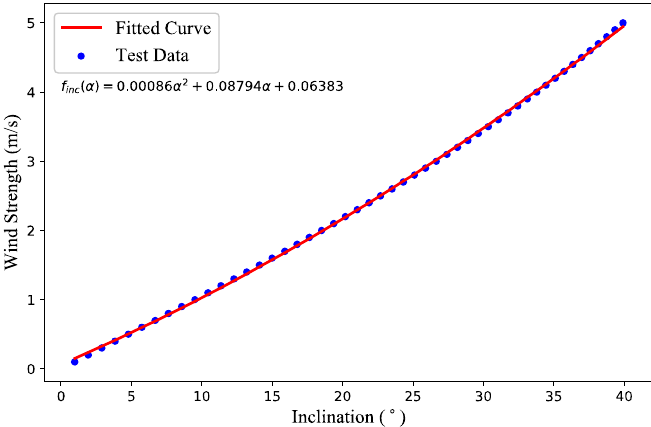
Figure 5. Fitting results of the inclination angles and wind strengths.